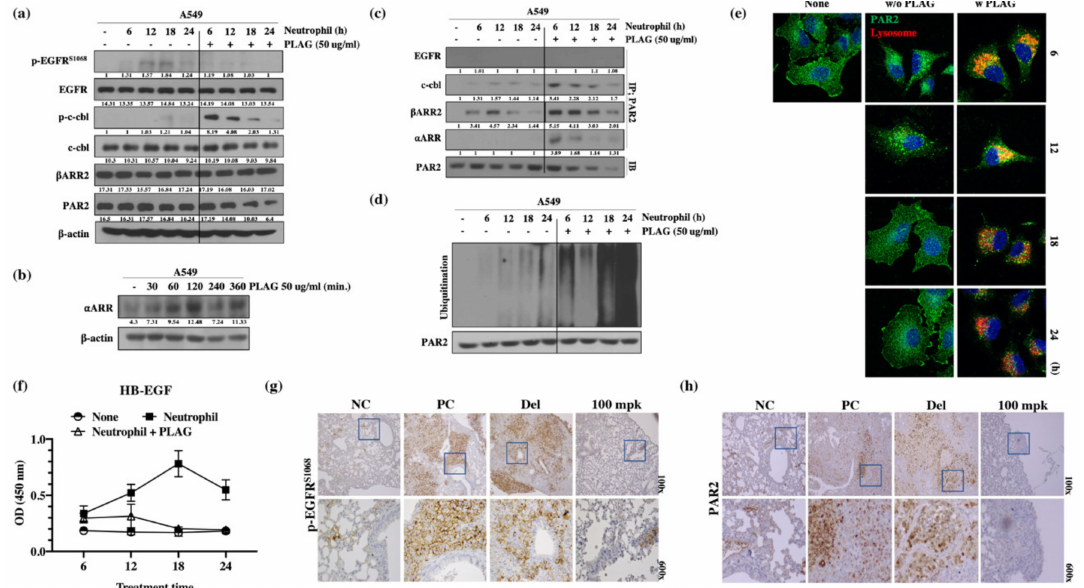
Figure 5. PLAG inhibition of EGFR transactivation mediated by the neutrophil elastase / PAR2 / β ARR2 signaling pathway in A549 cells: ( a ) Inhibition of the EGFR signaling pathway and PAR2 degradation by PLAG treatment in neutrophil-stimulated A549 cells evaluated by Western blot; ( b ) Induction of α ARR expression by PLAG treatment was confirmed by Western blotting; ( c ) Changes in complex formation between endocytosis-related proteins and PAR2 degradation following PLAG treatment; ( d ) Validation of the PAR2 ubiquitination-inducing e ff ect of PLAG in neutrophil-activated A549 cells; ( e ) Lysosomal PAR2 degradation in PLAG-treated cells was verified by confocal microscopy; ( f ) Changes in HB-EGF secretion following PLAG treatment and neutrophil stimulation in A549 cells; ( g ) Phosphorylation of EGFR; ( h ) and expression of PAR2 in the lung tissues of A549-orthotopically implanted mice were prominently reduced by PLAG